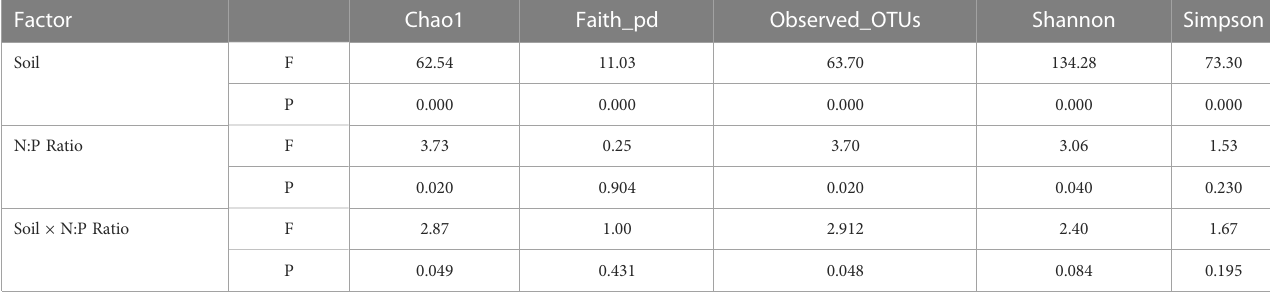
TABLE 1 Two-way ANOVA of a -diversity of bacterial community.